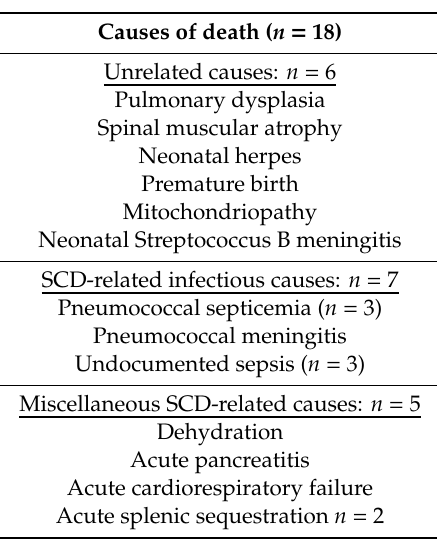
Table 3. Overall causes of death.